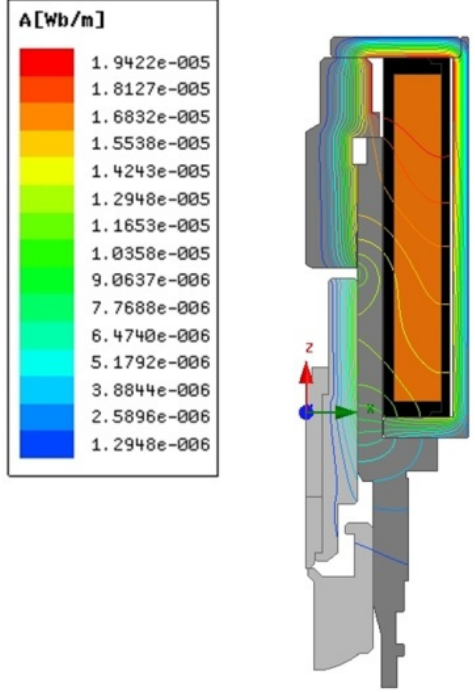
Figure 12. Contour of magnetic flux lines at ambient temperature and 100% duty ratio.